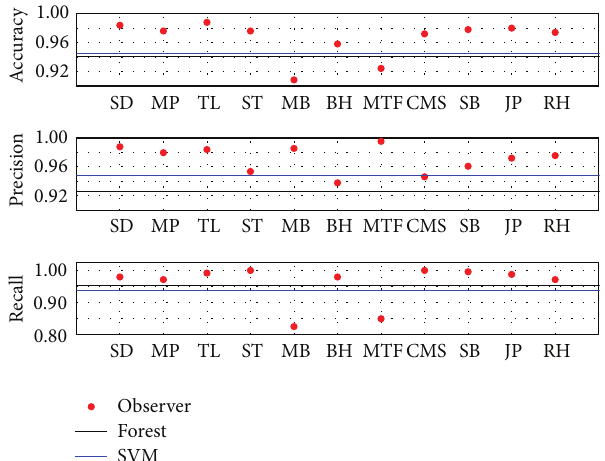
Figure 5: The accuracy, precision, and recall of observers (dots), RF (black line), and SVM (blue line) with the consensus annotation of the 502 cutouts for which consensus could be